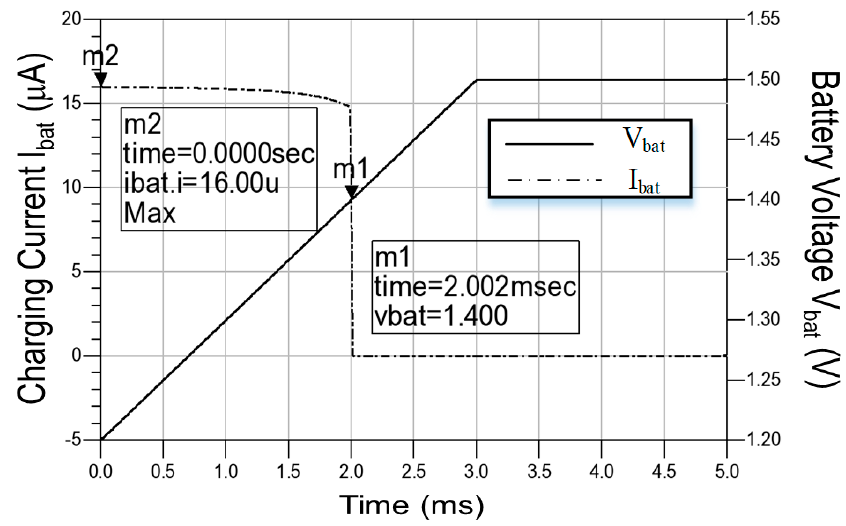
Figure 14. Simulated battery voltage and charging current of the charger control circuit.